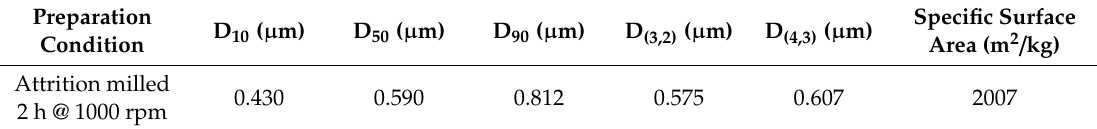
Table 1. Laser particle-size test results of submicron-scale LLZNO powder.